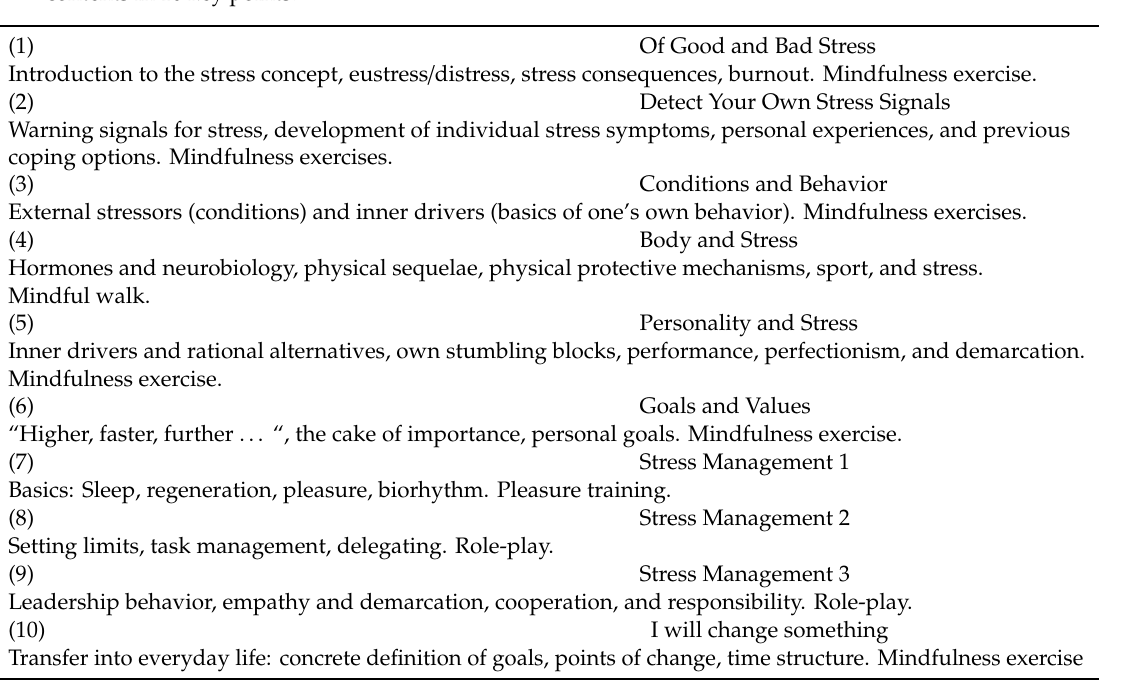
Table 1. Stress-management intervention (SMI)—Psychoeducation and psychological coaching—the contents in 10 key